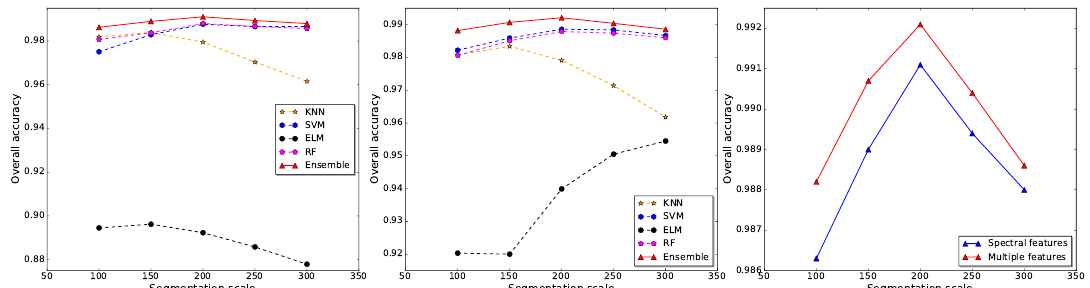
Figure 5. ( a ) Accuracies of OBCD with spectral features and different classifiers for various segmentation scales; ( b ) accuracies of OBCD with multiple features and different classifiers for various segmentation scales; ( c ) accuracies of OBCD with EL and different feature selection strategies for various segmentation